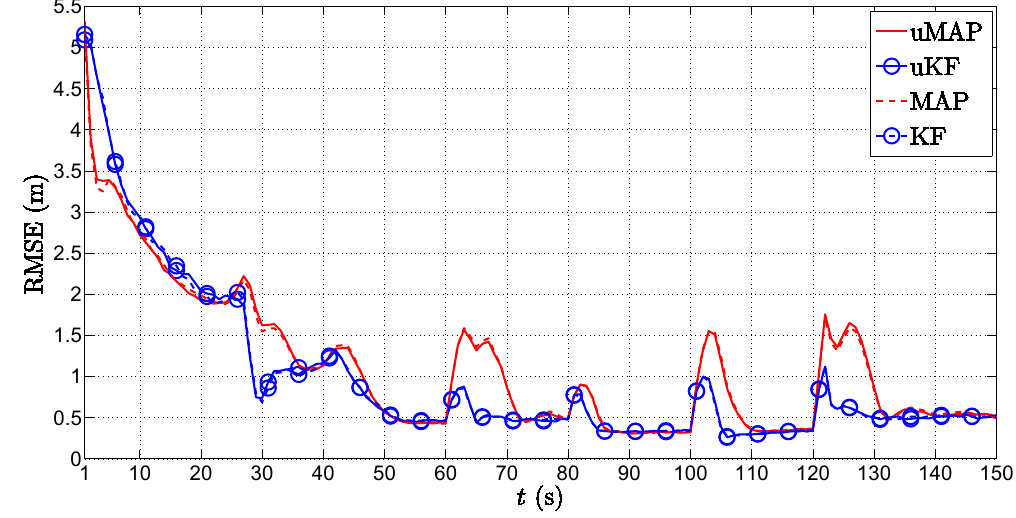
Figure 7. RMSE (m) versus t (s) comparison in the first scenario, when N = 2, (cid:107) v a (cid:107) = 1 m/s, = 9 dB, σ m = 4 π σ n rad, γ = 3, γ i ∼ U [ 2.7,3.3 ] , τ = 5 m, P 0 = − 10 dBm, q = 2.5 × 10 − 3 m 2 /s 3 , 180 i i M c = 1000.